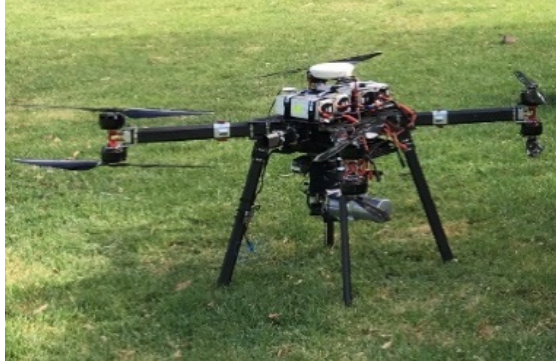
Figure 2. The UAV used for data collection.